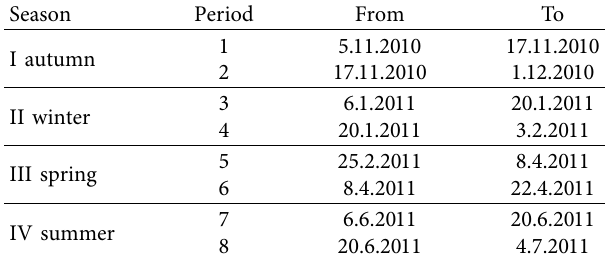
Table 2: The measurement periods. Season